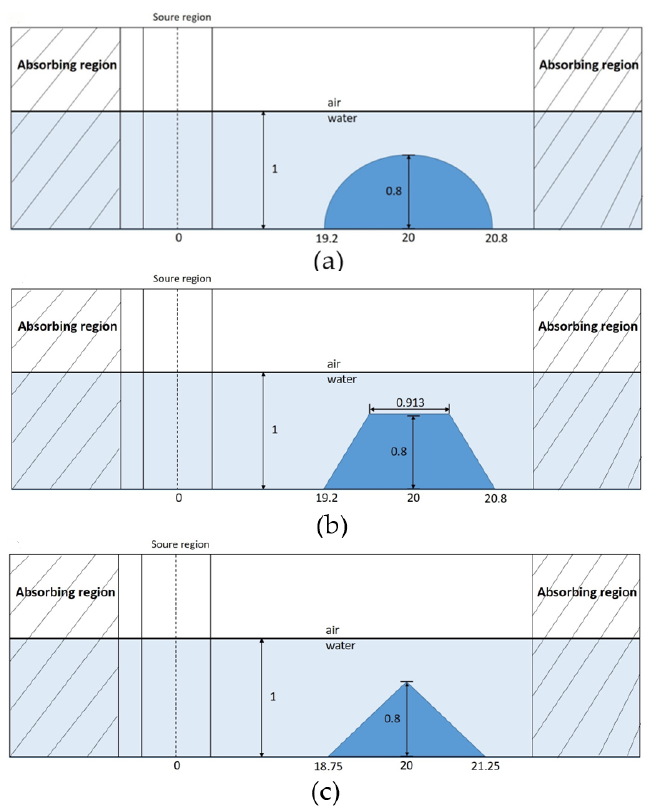
Figure 10. Sketch of the computational domain; for the submerged structures, ( a ) semicircle, ( b ) trapezoidal, and ( c ) triangular with the cross area of 1 m 2 and height of 0.8 m.